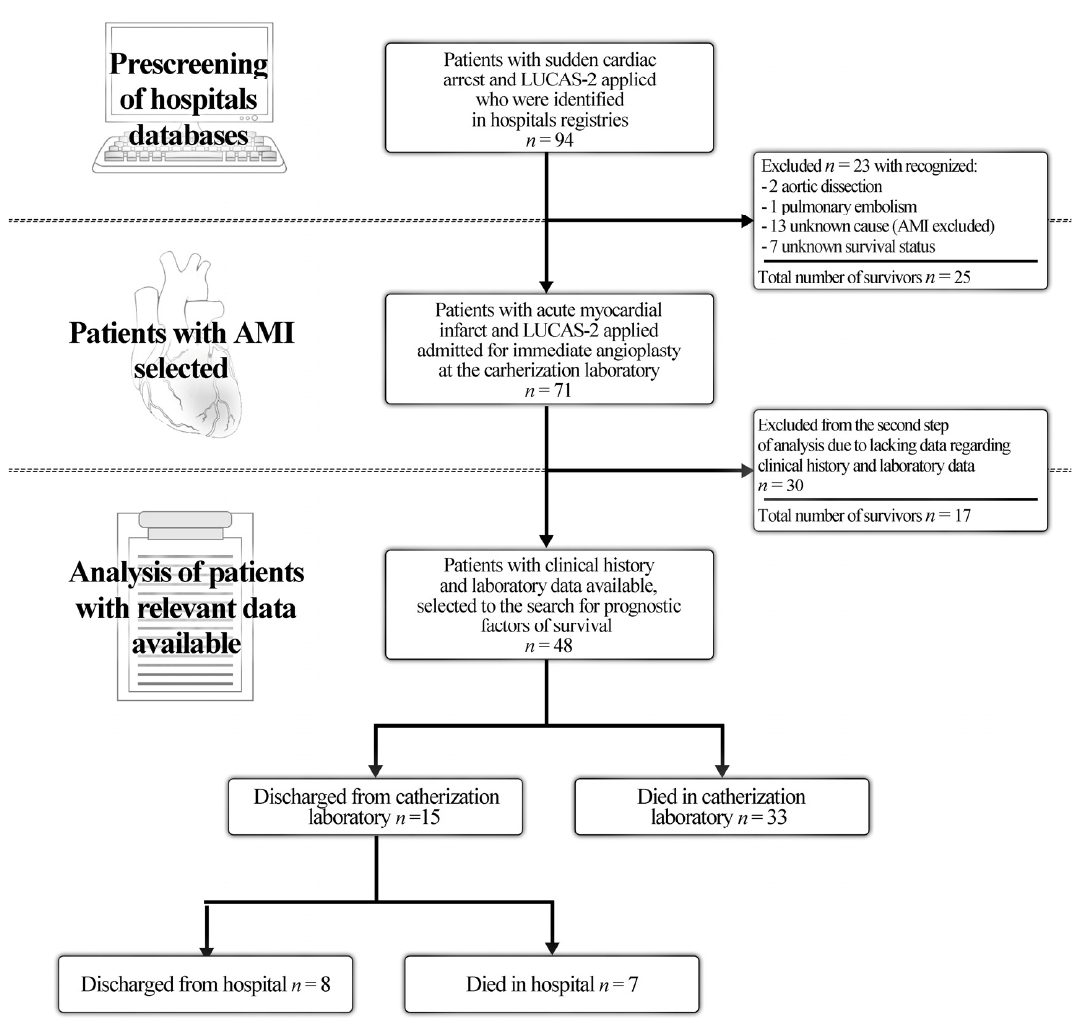
Figure 1. The study flowchart. The particular steps of data acquisition and analysis are shown. AMI: acute myocardial infarction. AMI: Acute Myocardial Infarction; LUCAS-2 Lund University Cardiac Assist System 2.